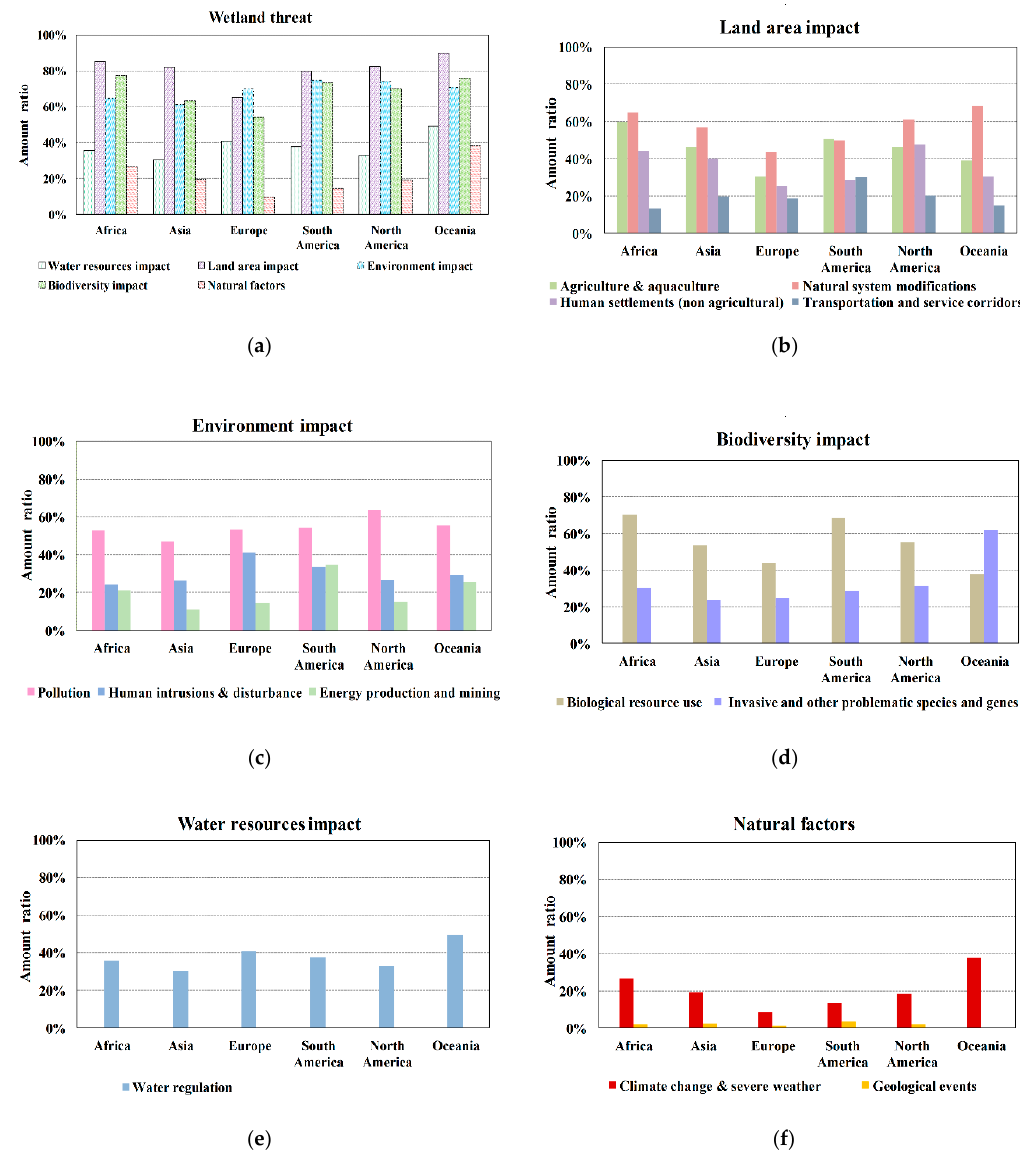
Figure 4. The amount ratios of impact factors to Ramsar Sites in each continent; (a) is for total impact factors; (b) is for land area impact; (c) is for environment impact; and (d) is for biodiversity impact; (e) is for water resources impact; and (f) is for natural factors.